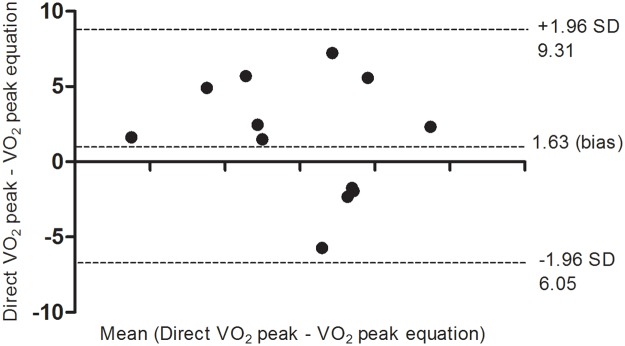
Bland-Altman agreement of VO2 peak in the validation of the reference equation.